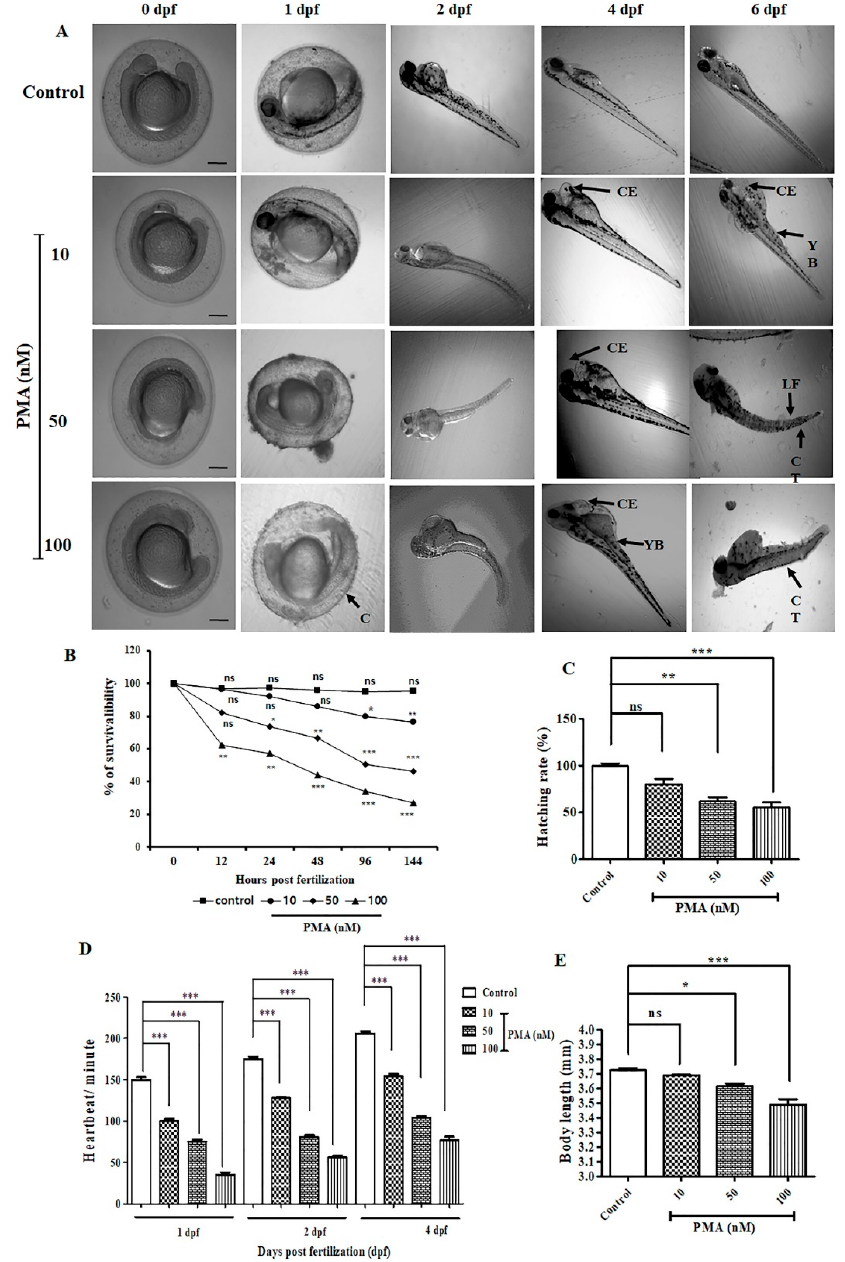
Figure 2. PMA exerted various deformities in zebrafish embryo and larvae ( n = 10/group). ( A ) Morphological images of the development of zebrafish embryo to larval stage. Images were captured from 0.5–6 dpf. Common observed deformities were C (coagulation), CE (cardiac edema), CT (curved tail), LF (lack of tail fins), YB (development of yolk bags. Scale bar = 200 μ M at 4× magnification. ( B ) Percentage of survivability ( C ) Percentage of hatching rate ( D ) Determination of heartbeat per minute of on 1 dpf, 2 dpf, and 4 dpf. ( E ) The data are represented as the means ± S.D. of three independent experiments * p < 0.05, ** p < 0.01, *** p < 0.001 and ns (non-significant). Statistical significance analysis was carried out through a one-way analysis of variance (ANOVA) prism.